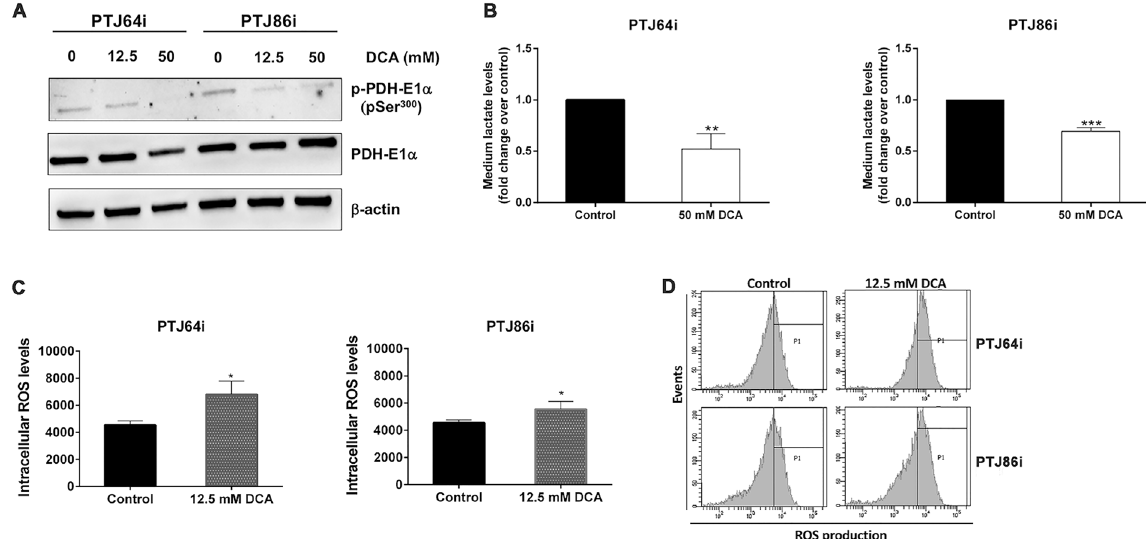
Figure 2. DCA inhibits PDK, decreases extracellular lactate and increases intracellular ROS levels in PTJ64i and PTJ86i cell lines. (A) Western blot analysis of p-PDH-E1 α (pSer 300 ) and PDH-E1 α proteins after incubation of PGL cells for 24 hours with vehicle or DCA at the indicated concentrations; (B) Histograms represent quantification of extracellular lactate levels in the culture media of PGL cell lines treated with DCA or vehicle (control) for 24 hours. Data shown are the means ± SD of three replicates and are expressed as fold change relative to vehicle (control) ( ** p < 0.01; *** p < 0.001); (C) Intracellular ROS levels in PTJ64i and PTJ86i cells measured by flow cytometry after a 24–hour treatment with DCA or vehicle (control). Data shown are the means ± SD of three independent experiments ( * p < 0.05); (D) Representative CM–H2DCFDA histograms derived from flow cytometry analysis showing ROS production in PTJ64i and PTJ86i cells after a 24–hour treatment with DCA or vehicle (control). Full–length western blots are included in Supplementary Information (Fig.